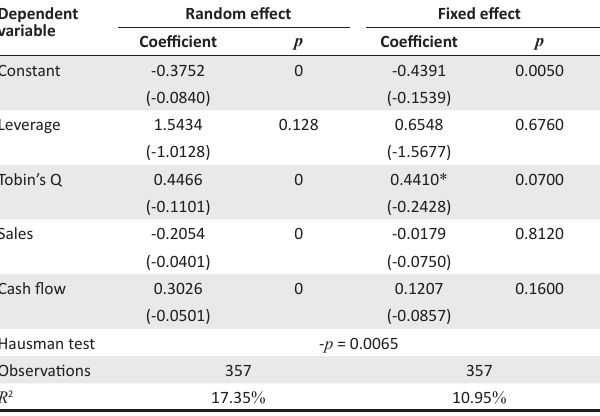
TABLE 4: Regression results for Equation (1) using long-term debt as a proxy of